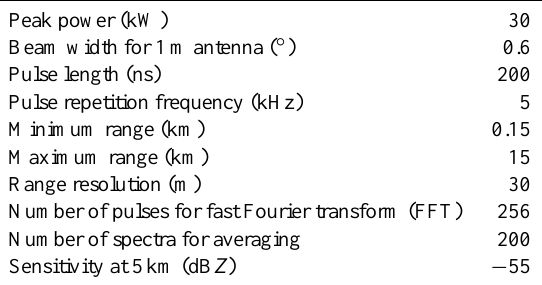
Table 1. Parameters of MIRA-35 used in the operational mode.